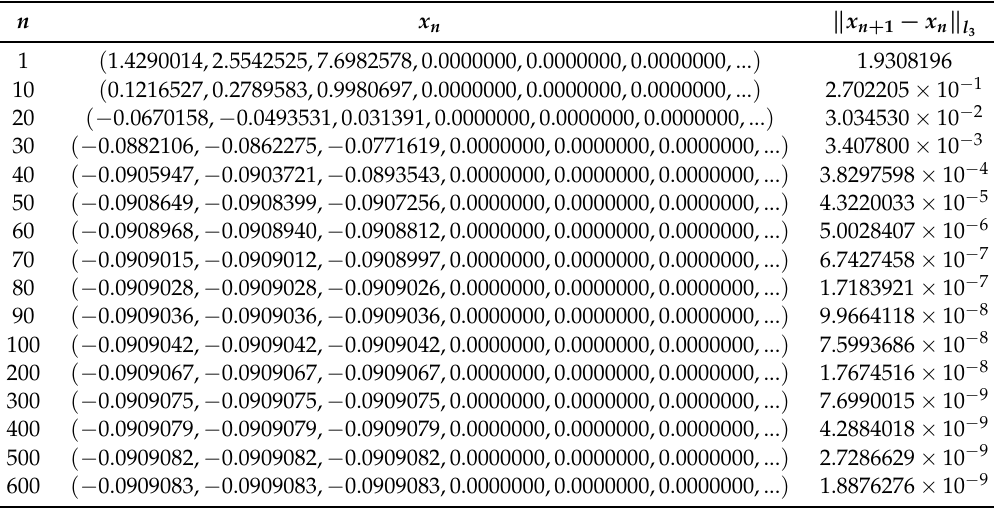
Table 2. Numerical results for iteration process Algorithm (1) with α n = 0 in Example